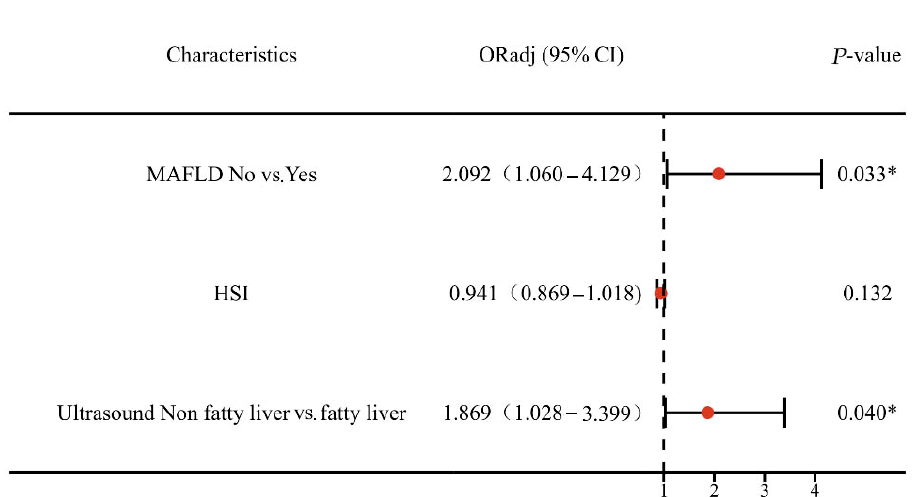
Figure 3. The Multivariate Logistic Regression Analysis for CSI among Type I EC Patients. Abbreviations: HSI: hepatic steatosis index; MAFLD: metabolic dysfunction-associated fatty liver disease; EC: endometrial cancer; p -value: p value adjusted for age, BMI and histologic grade. * p < 0.05 was considered to be statistically significant. Table 4. Univariate and Multivariate Logistic Regression Analysis of Independent Risk Factors for CSI in Type I EC Patients without